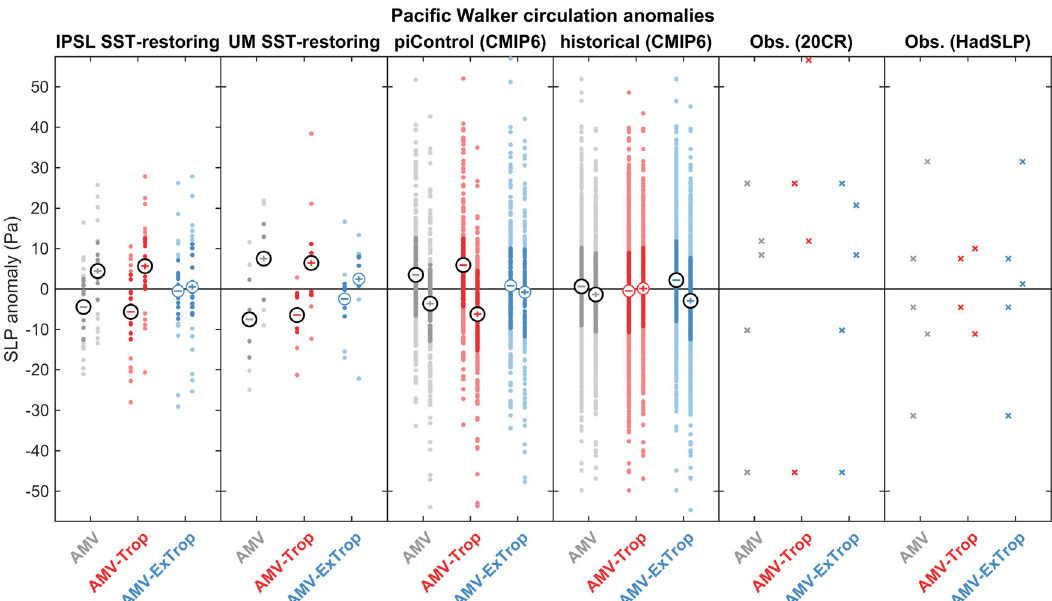
Fig. 4 Relationships between the Paci fi c Walker Circulation and the AMV. Decadal Paci fi c Walker circulation anomalies for SST + and SST- ensembles for the SST-restoring simulations. Also shown are the equivalent for the SST + and SST- periods from the free-running historical and piControl CMIP6 simulations. Each dot indicates a single decadal period from one simulation, the darker shading indicates the interquartile range of the distributions and the circles with the “ plus" and “ minus" signs show the ensemble mean anomalies for the SST + and SST- ensemble simulations, respectively. The circles surrounding the “ plus" and “ minus" signs are black and emboldened when the difference in the ensemble mean are signi fi cantly different at the 95% level based on a t-test. The equivalent data points are also shown for two observational datasets, 20CR and HadSLP2, with each decade shown by a